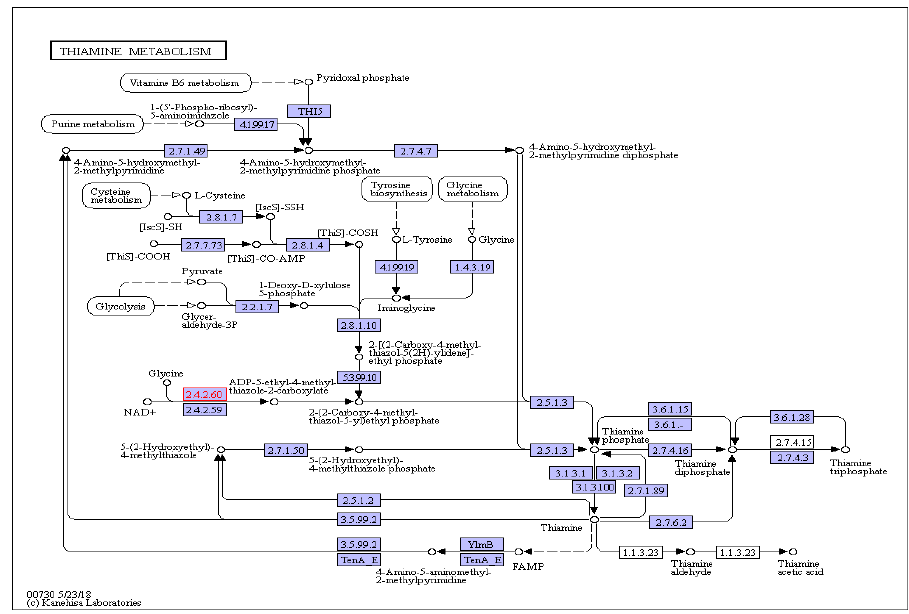
Figure 7. A. marmelos leaf transcriptome encoded enzymes (highlighted) involved in the thiamine biosynthetic pathway identified in the leaf.